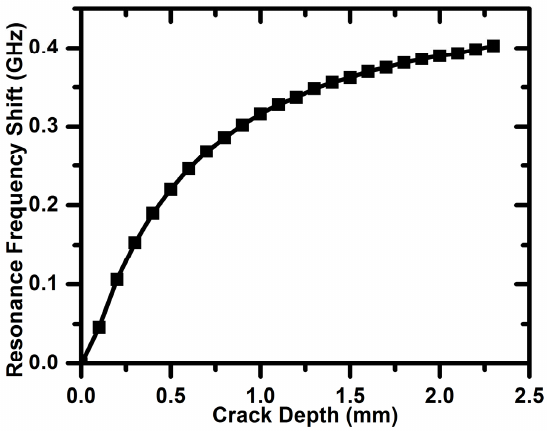
Figure 9. Resonance frequency shift as a function of the crack depth. The crack is 0.2 mm wide and 10 mm in